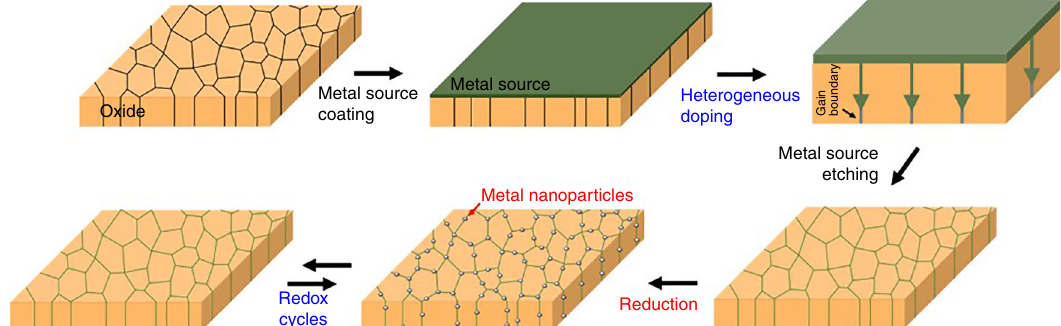
Fig. 1 Synthesis of metal nanoparticles. Schematic diagram of the overall synthesis procedures of metal nanoparticles and their self-regenerative tendency according to redox